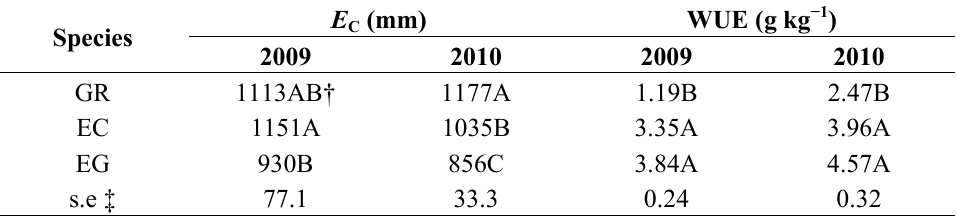
Table 3. Treatment means for seasonal crop transpiration (EC) and water use efficiency (WUE; g aboveground dry matter kg − 1 water transpired) of perennial grasses during the 2009 and 2010 growing seasons. Species include giant reed (GR), energycane (EC), and elephantgrass (EG).